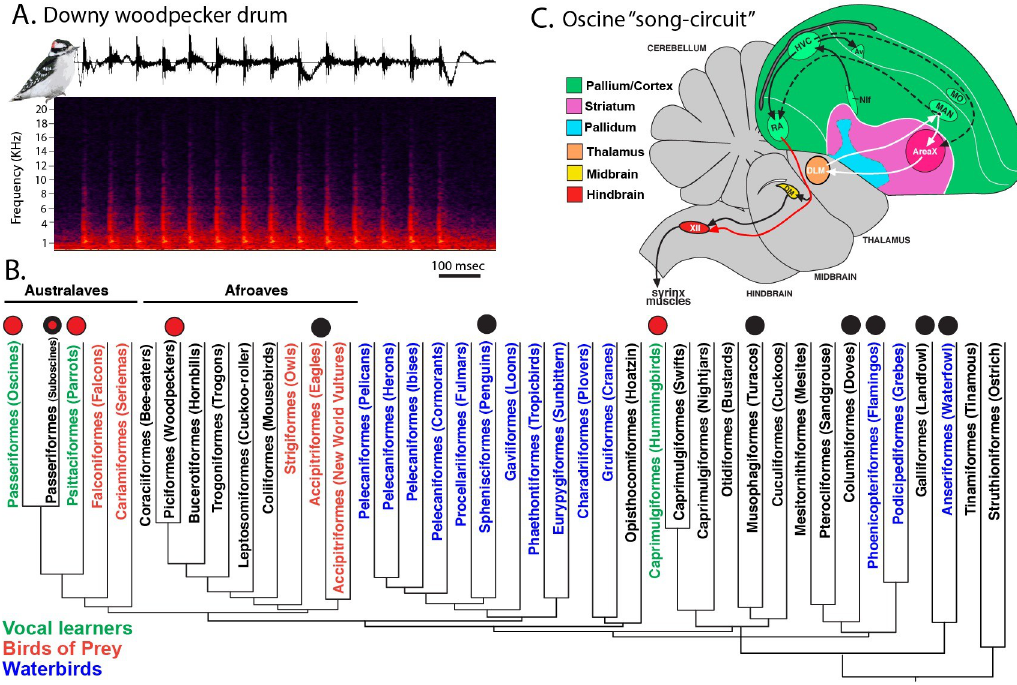
Fig 1. Brain regions identified for vocalization and drumming behavior across the avian phylogeny. (A) Waveform and spectrogram diagrams of a spontaneous male downy woodpecker drum recorded at dawn during the breeding season. Image of downy woodpecker from Greg Schechter (CC Public Domain via WikiMedia). (B) Avian phylogeny from [73] further annotated where specialized brain regions have been either identified [red circles: oscine songbirds, parrots, hummingbirds; red circle with black outline: suboscines, which only has RA-like nucleus), and woodpeckers] or investigated and not found (black circles). Note that this figure includes the 7 genera never examined before our current study. (C) Schematic diagram of the oscine “song circuit” that is characterized by a set specialized forebrain song nuclei essential for producing learned vocalizations. This circuit is composed of 2 main interconnected neural pathways: the vocal motor pathway (VMP; HVC and RA) and anterior forebrain pathway (AFP; LMAN, Area X, and DLM). While the VMP is necessary for both the acquisition and production of learned song, the AFP largely only necessary for